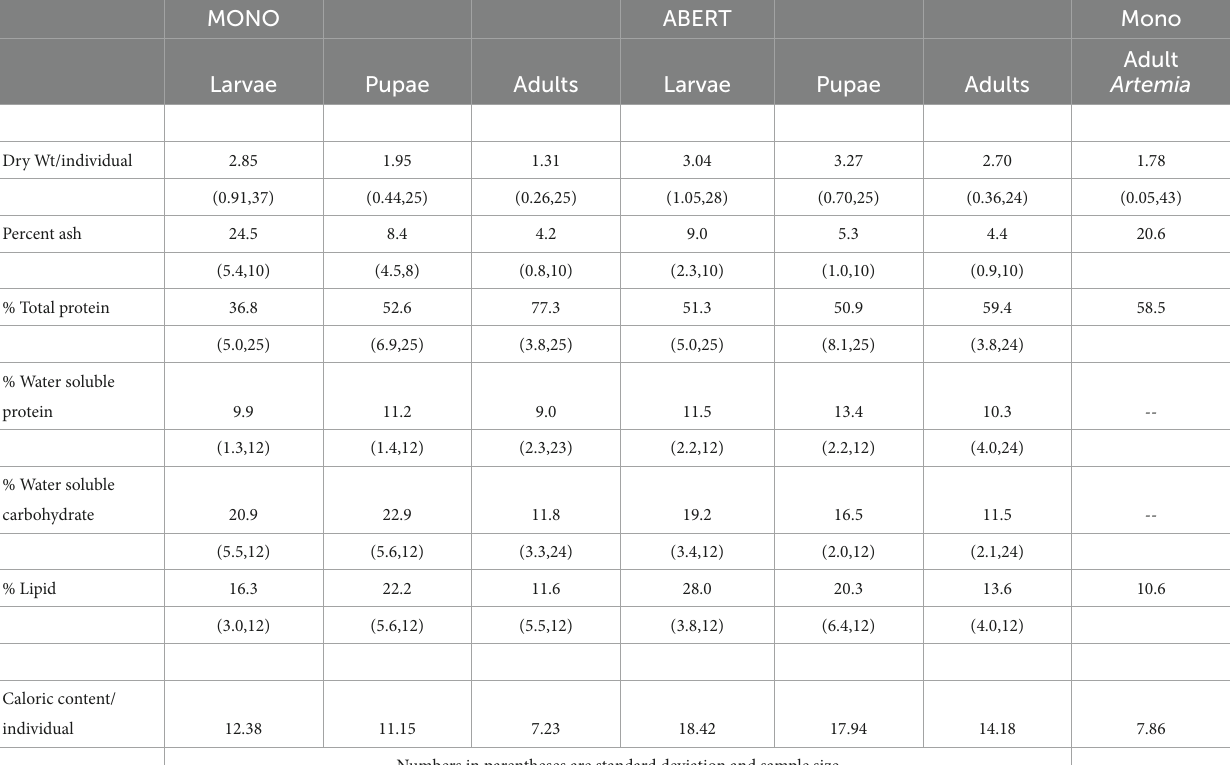
TABLE 1 Potential food value to birds foraging at lakes of differing salinity. Indicated here by proximate chemical analysis comparing life stages of Ephydra hians collected from Mono Lake with same from Lake Abert, and to Artemia brine shrimp from Mono